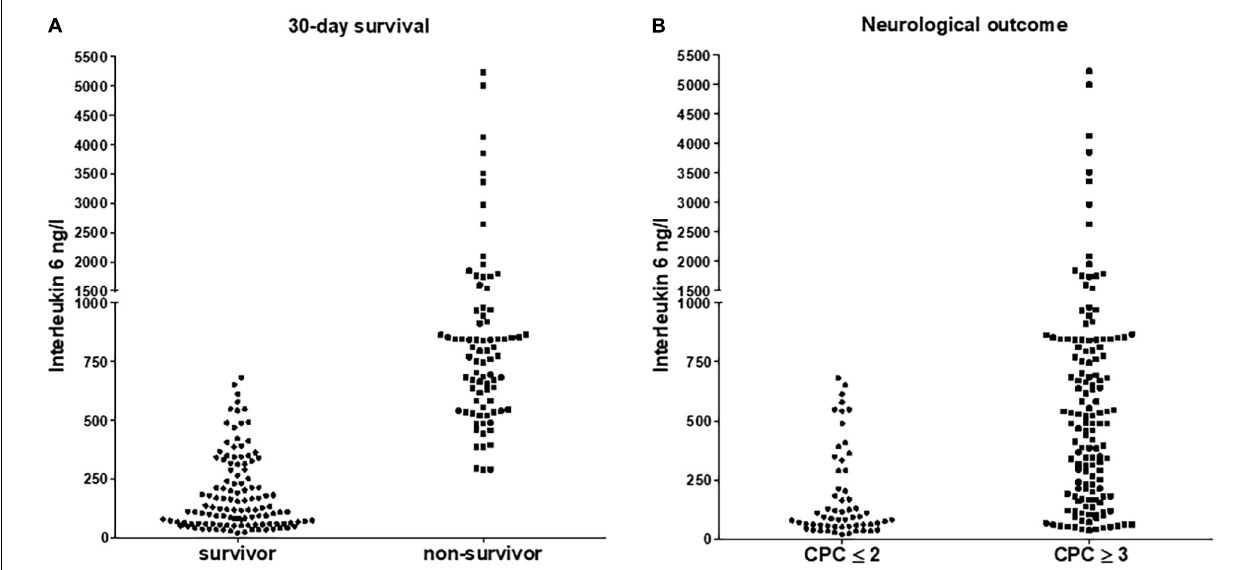
FIGURE 1 | Distribution of interleukin 6 according to 30-day survival (A) for survivors and non-survivors and according to neurological outcome (B) for patients with good (CPC ≤ 2) and poor outcome (CPC ≥ 3), respectively. For both p was < 0.05.